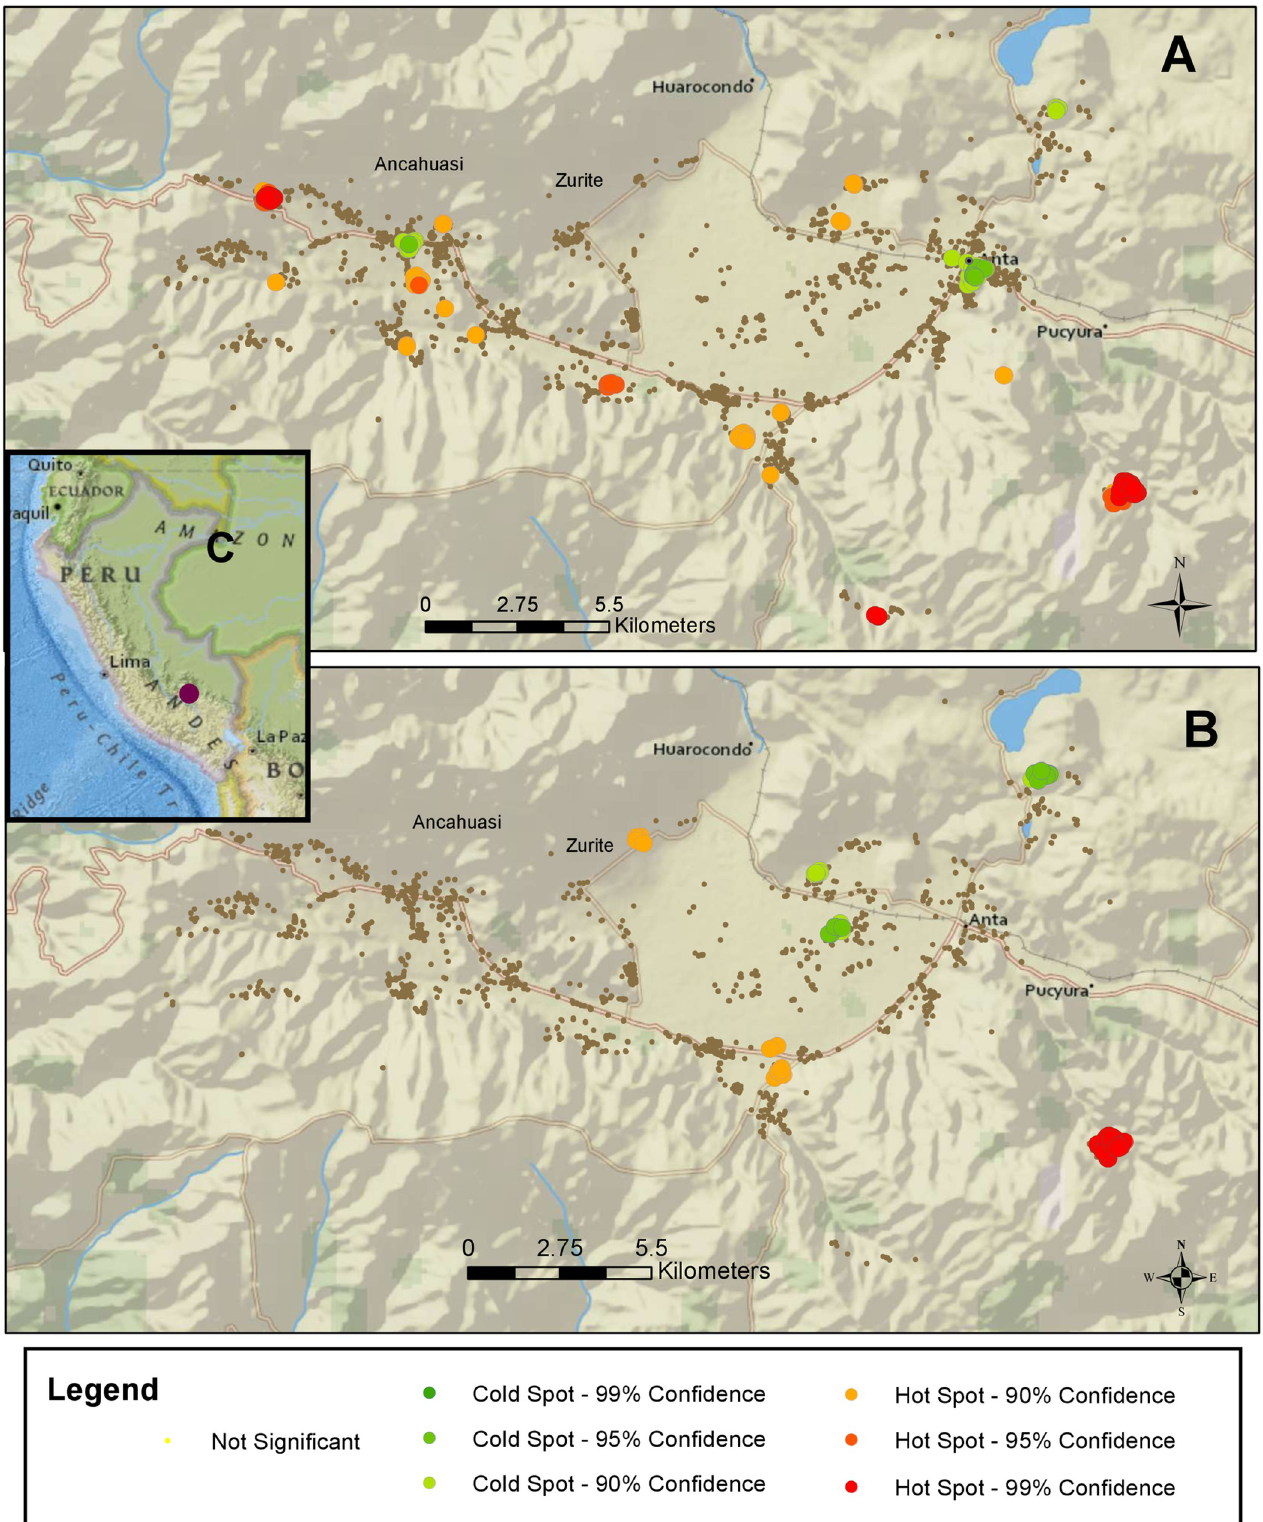
Fig 2. “Outlier and Cluster Analysis map based on Anselin Local Moran’s I statistic of all livestock and human Fascioliasis in the Anta province of Cusco, Peru” [21]. (A) Map based on infected and uninfected livestock and household infection status. (B) Map based on infected and uninfected livestock